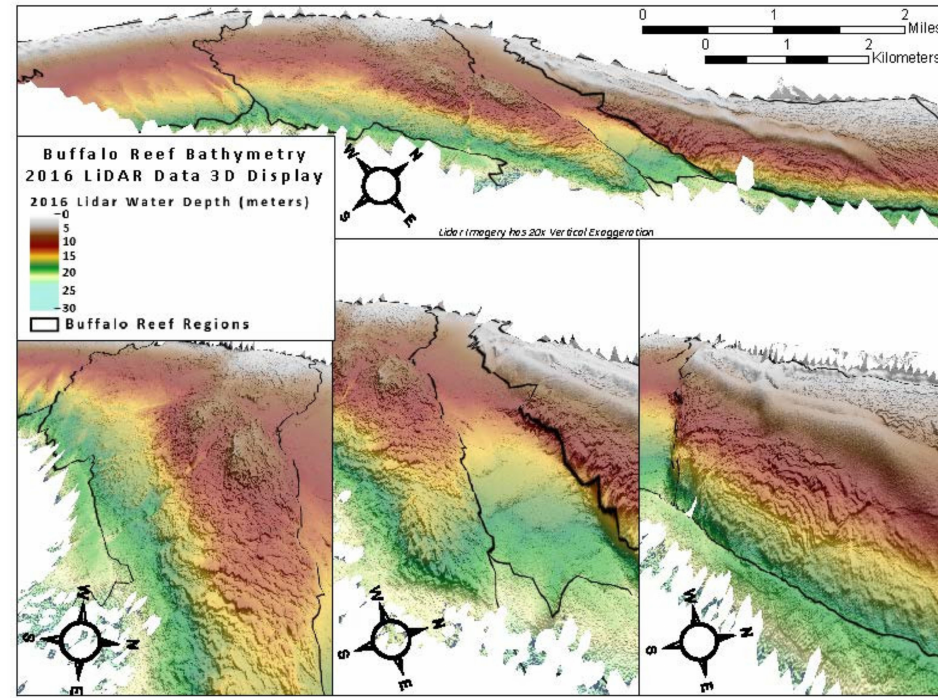
Figure 9. Buffalo Reef bathymetry. LiDAR DEM from 2016 overflights. Vertical relief is exaggerated by a factor of 20 and color-contoured with a hillshading effect (see depth in upper left legend). View is from the horizontal plane (ca. 15 ◦ ) with northern shadowing to emphasize 3D relief. Bottom panels are arranged from west to east, showing details of elevated bedrock rises, the ‘trough’ in the middle panel, and underwater migrating stamp sand bars moving across bedrock in the right panel. Black lines represent various bathymetric boundary regions used for analysis (see Figure